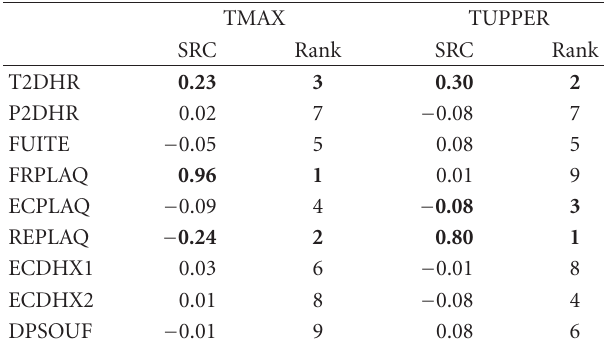
Table 4: Linear correlation standard regression coe ffi